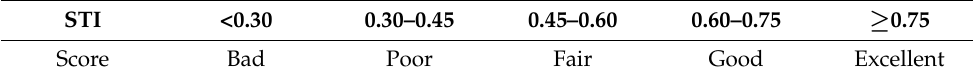
Table 6. Relation between speech transmission quality and speech transmission index (STI).